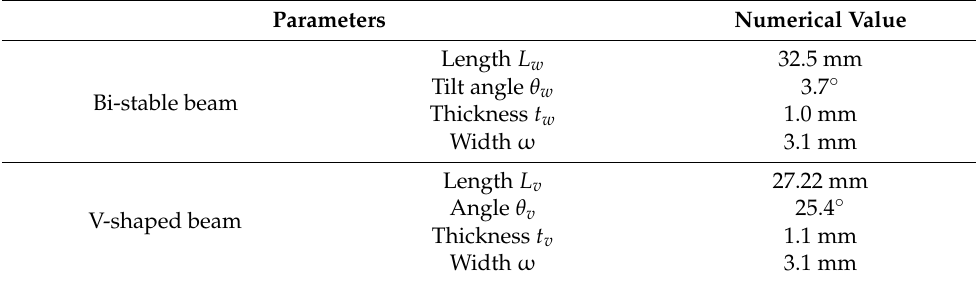
Table 2. Table of the parameters of the